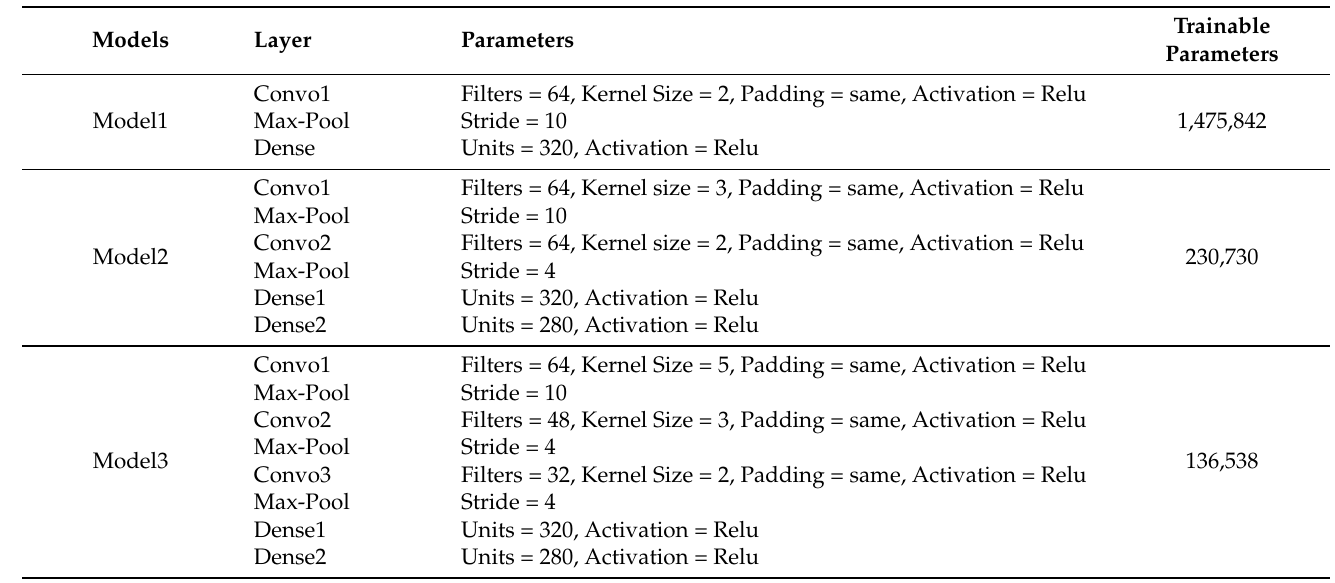
Table 4. Different Models Architectures of